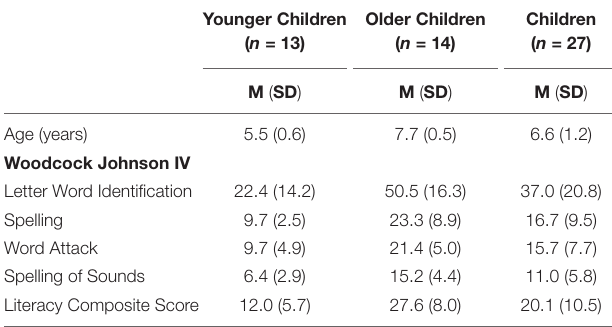
TABLE 1 | Mean and standard deviation of behavioral